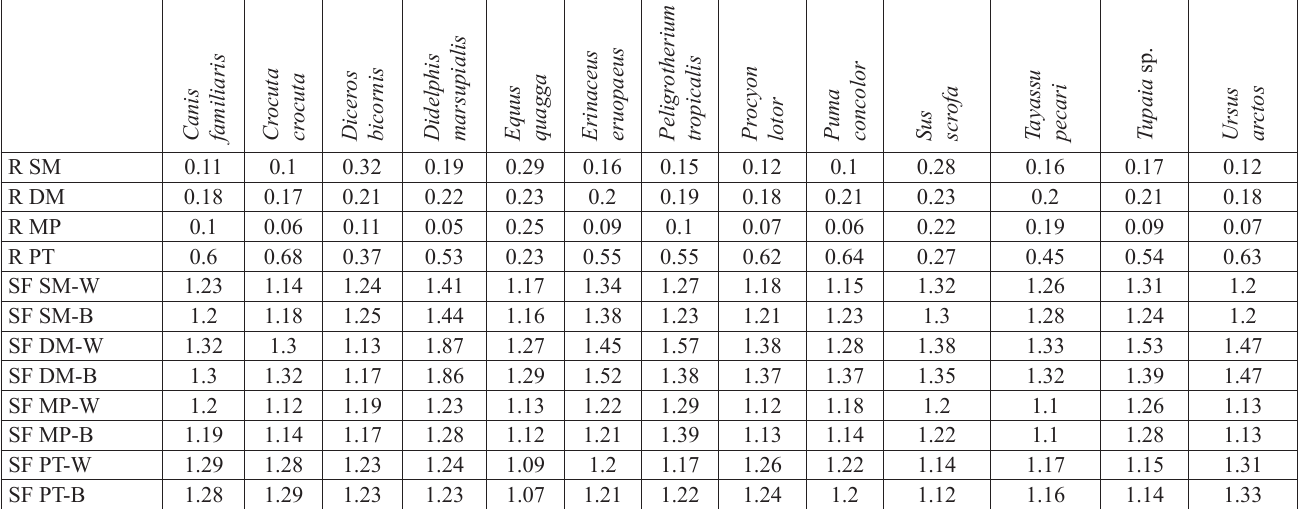
Table 2. Estimated relative force contributions and stretch factors measured in sampled taxa. Abbreviations: B, balancing-side; DM, deep masseter; MP, medial pterygoid; PT, posterior temporalis; R, relative contribution to total jaw adductor attachment area; SF, stretch factor; SM, superficial masseter; W,